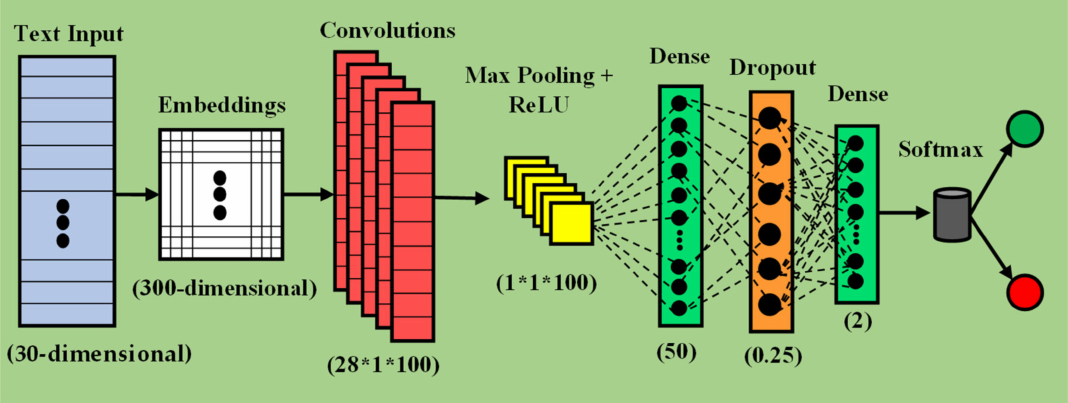
Figure 2. Architectural representation of proposed CNN